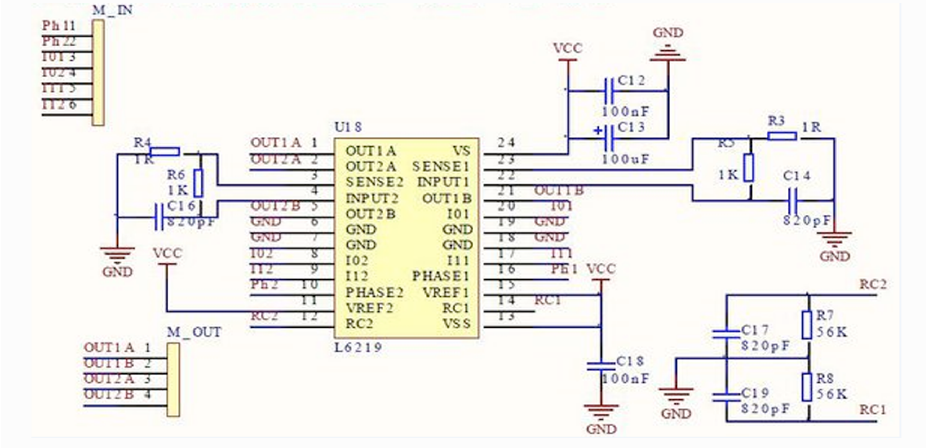
Figure 5. (cid:2)(cid:2) Switch ventilation window